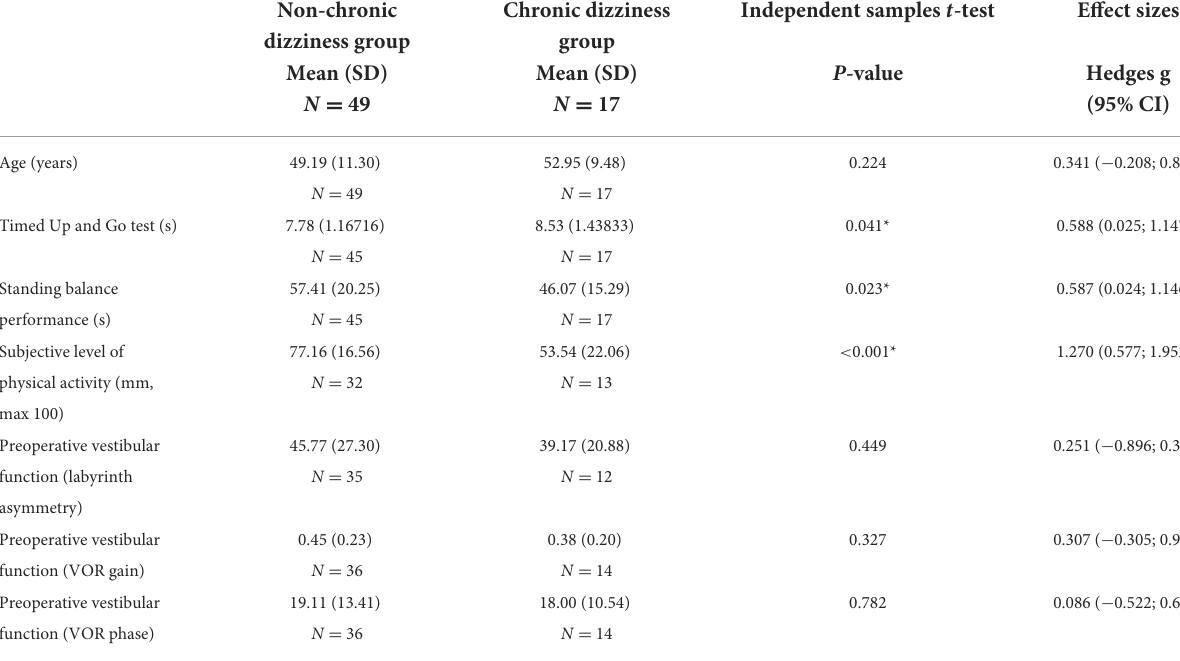
TABLE 1 Comparison of continuous variables between non-chronic dizziness and chronic dizziness groups.